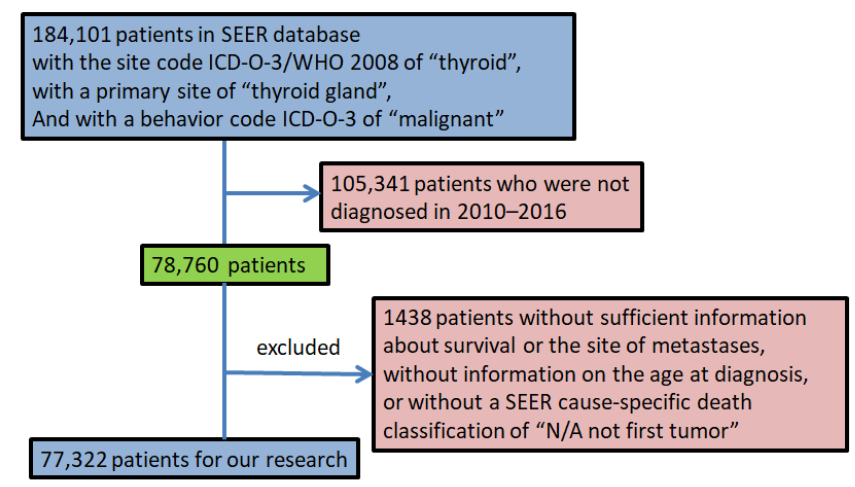
Figure 1. The workflow of patient selection process from the SEER database.